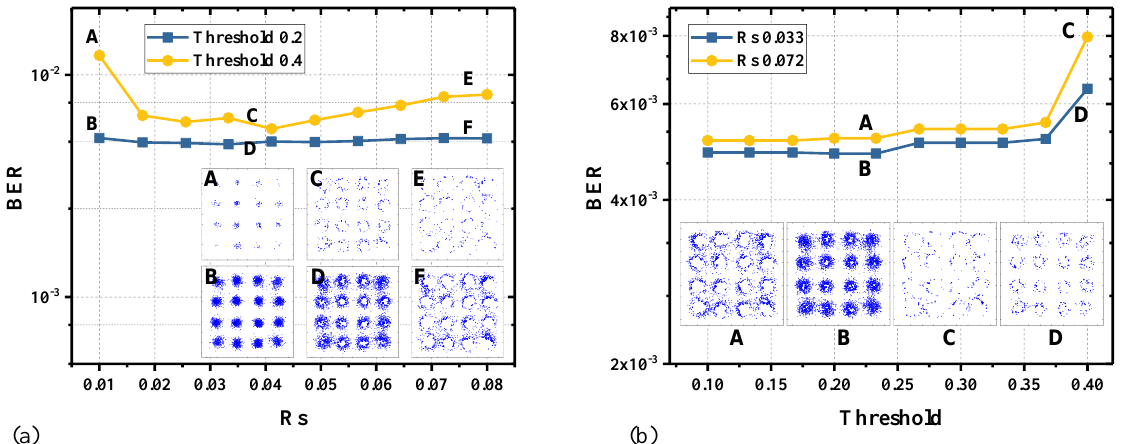
Figure 6. ( a ) BER versus the pixel-division size Rs and ( b ) BER versus the Sobel parameter Threshold at 1.6 Gbps.